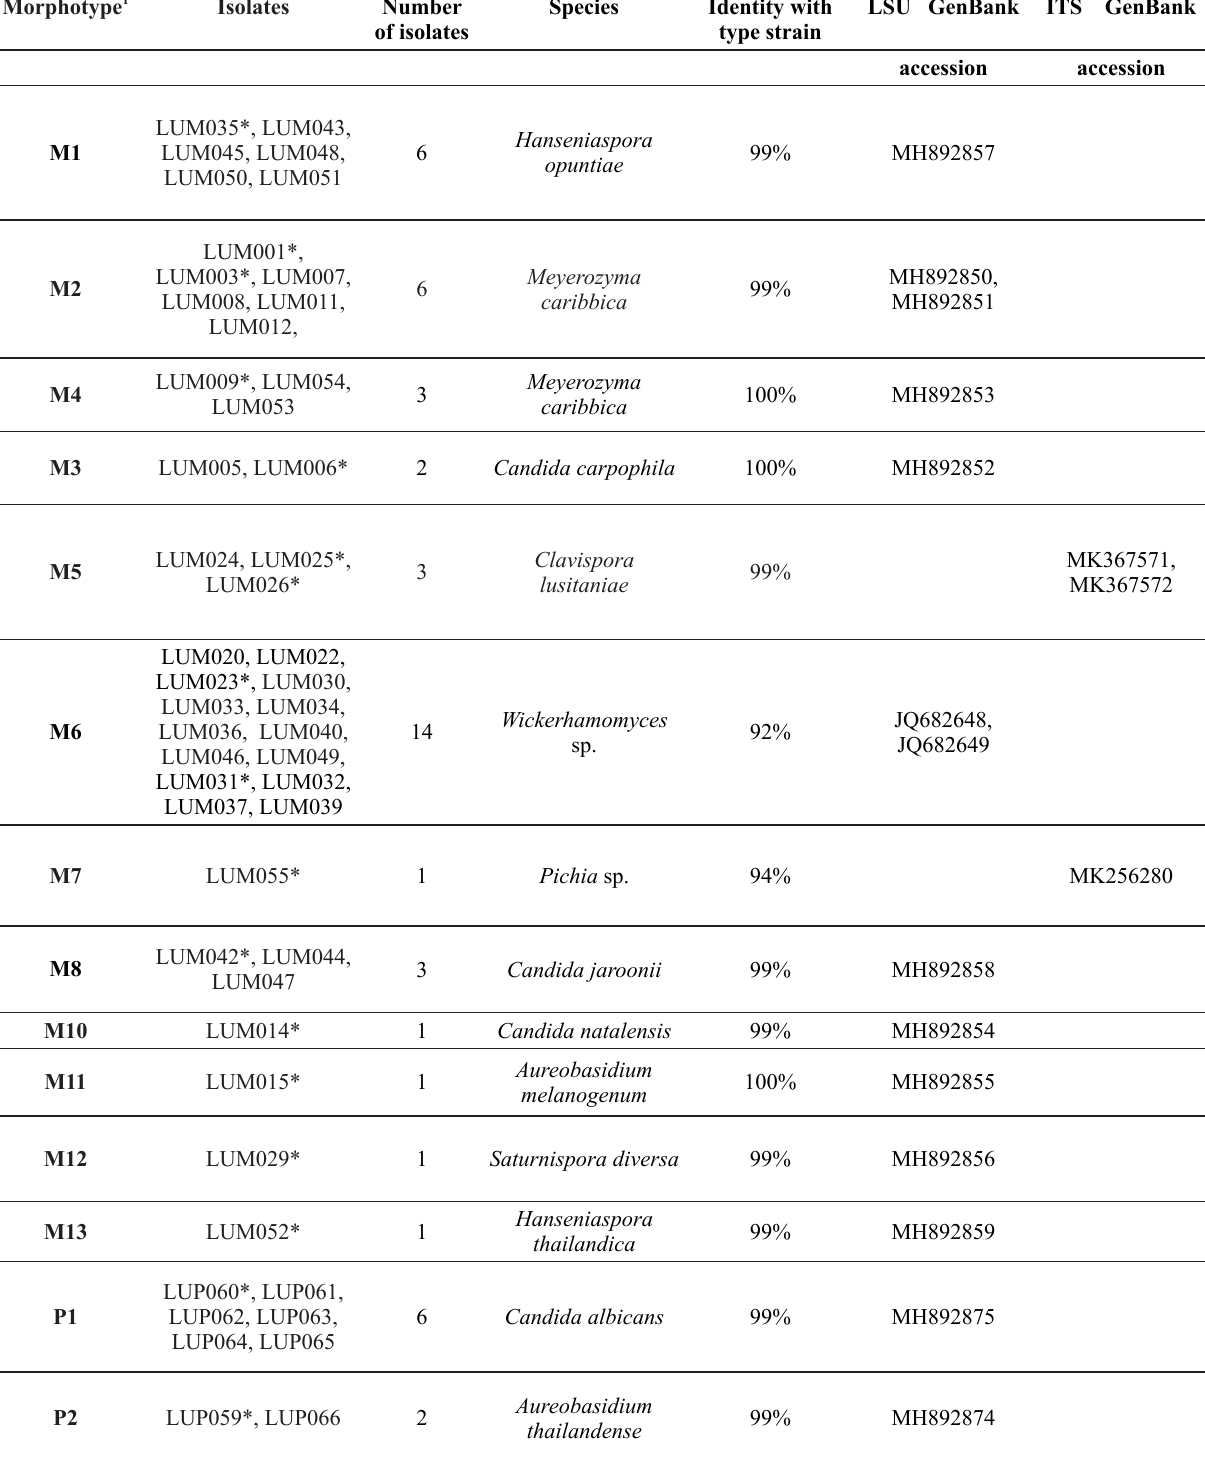
Morphotypes and identified yeast species using molecular